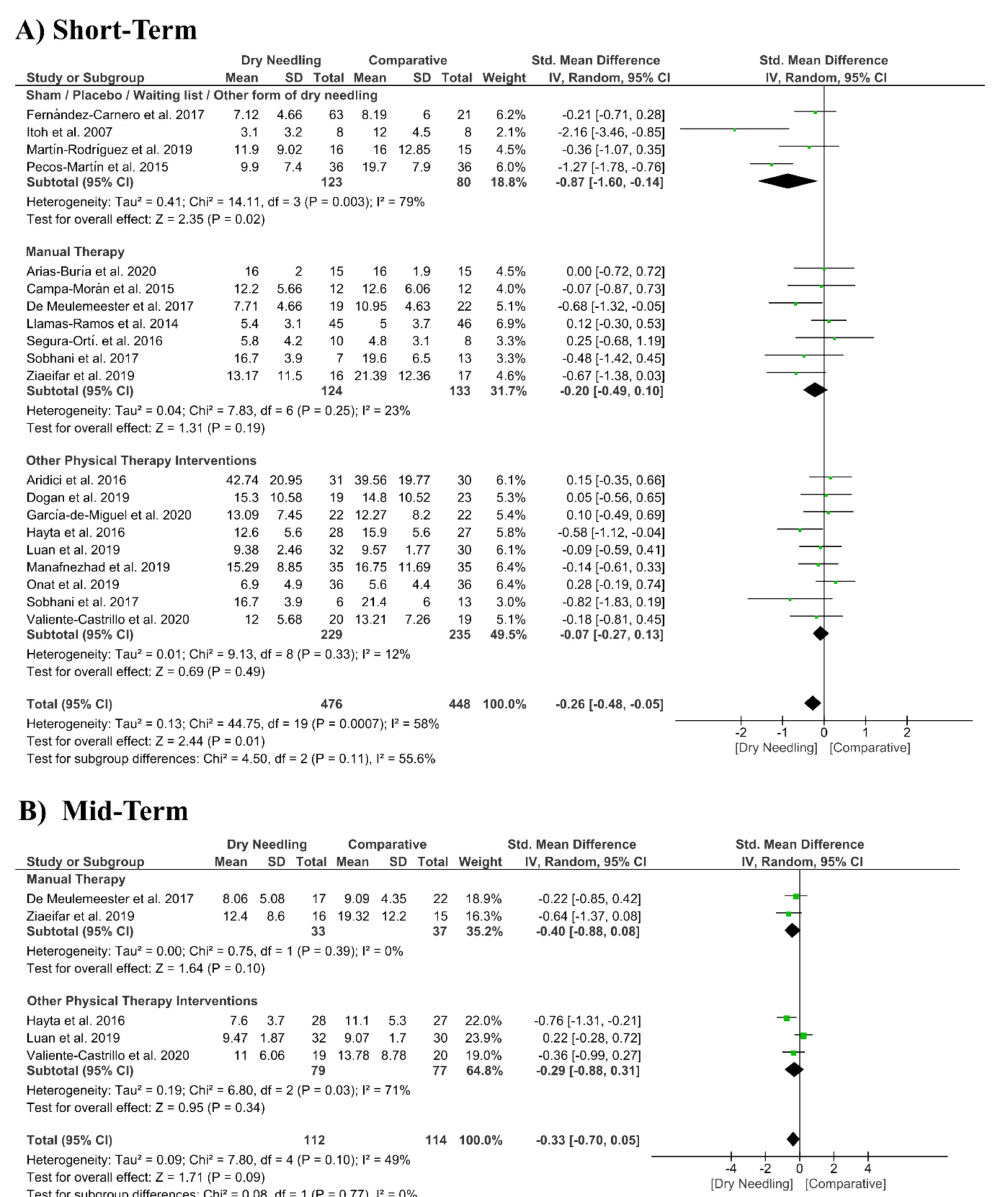
Figure 6. Standardized mean di ff erences (SMD) comparing the e ff ects of dry needling alone against sham / placebo / waiting list / other forms of dry needling or manual therapy or other physical therapy interventions on pain-related disability at the ( A ) short- and ( B ) mid-terms. SD:standard deviation; CI: confidence